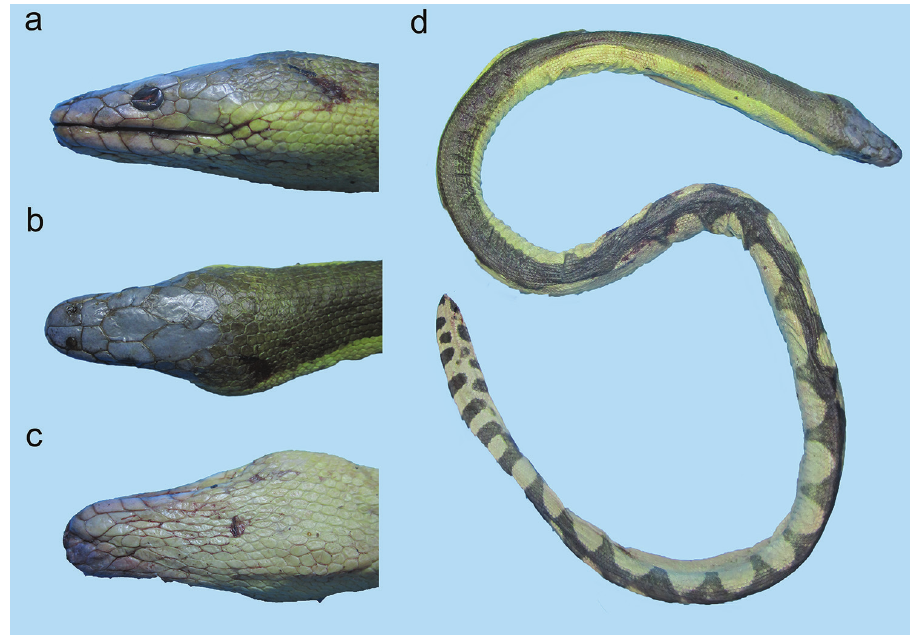
Figure 13. Hydrophis platurus : a lateral view b dorsal view, and c ventral view of head d